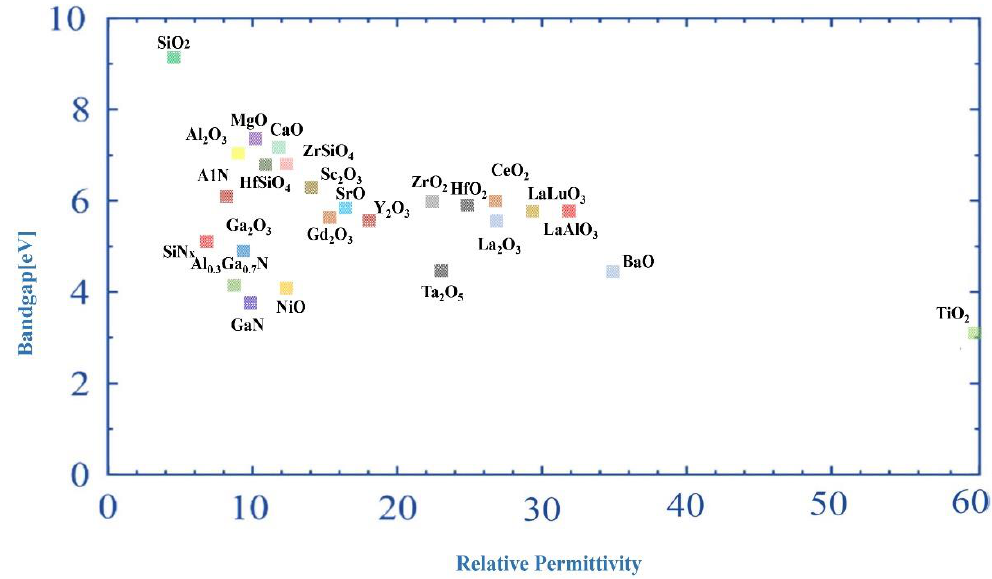
Figure 24. For primary insulators and GaN compounds, the energy bandgap (eV) vs. permittivity is shown. Reprinted with permission [42]. Copyright 2017, the author(s). Published by Elsevier.